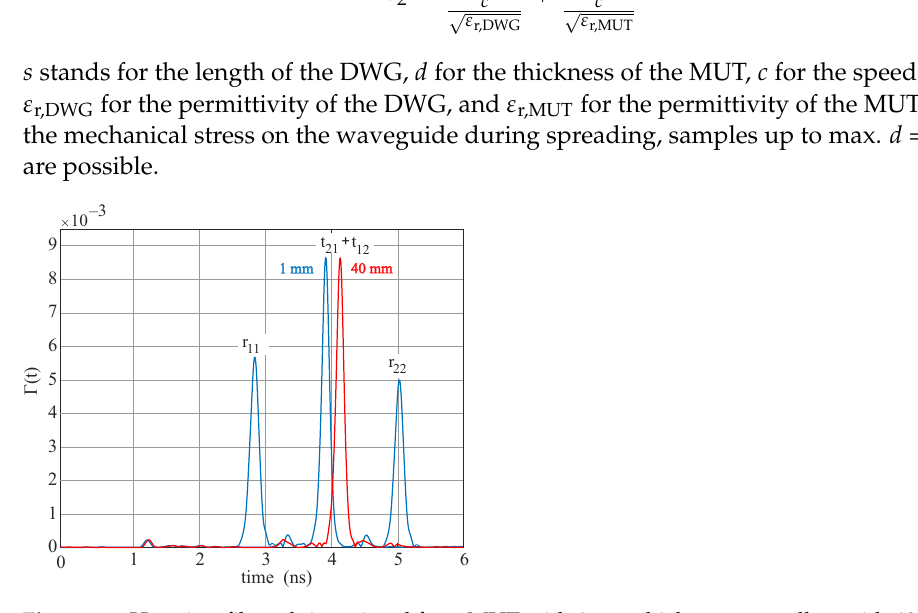
Figure 16. Hanning-filtered time signal for a MUT with 1 mm thickness, as well as with 40 mm. With the extension, samples up to 20 mm with a permittivity between 1 and 80 can be